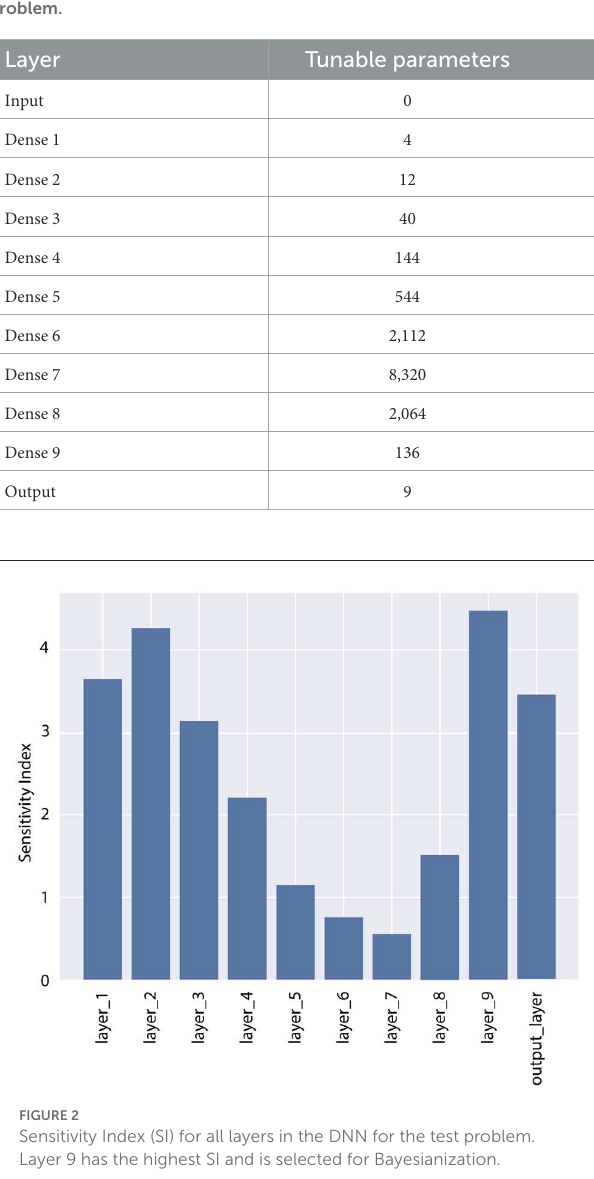
TABLE 1 Architecture of the densely-connected DNN used for the test problem.